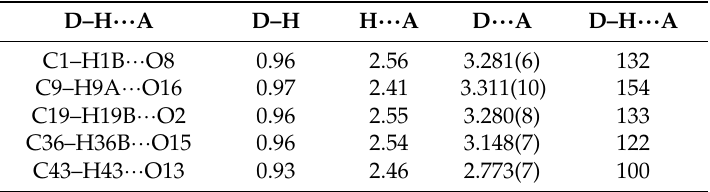
Table 4. Hydrogen bonding interactions (Å, ◦ ) of the Zn II –Eu III complex.